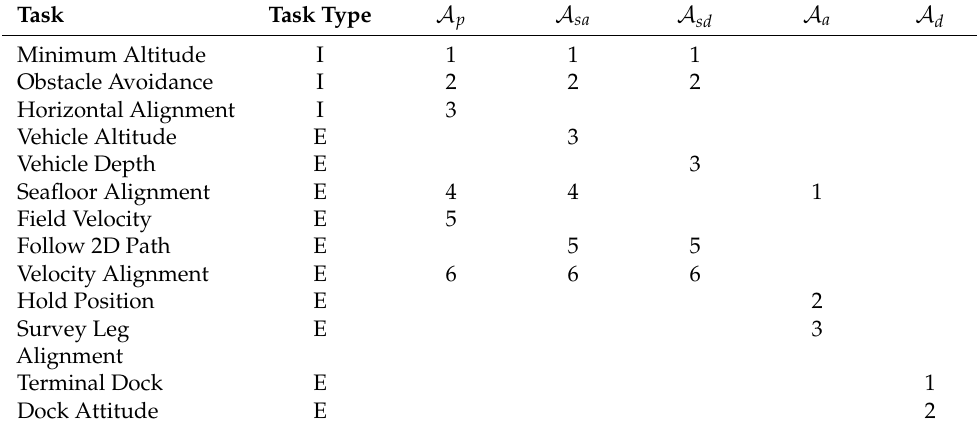
Table 1. List of tasks in actions that encompass the various behaviors of the vehicle. In task type, I refers to an inequality objective and E refers to an equality objective. The numbers denote the priority of each task in their respective action where lower values represent a higher priority for that task in the